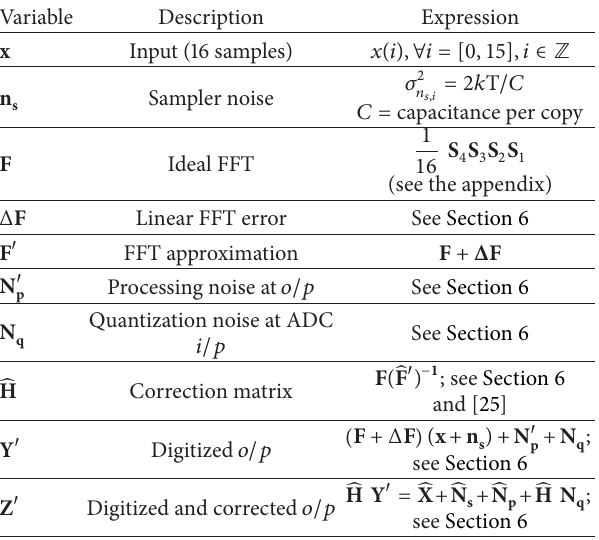
Table 1: Summary of variables in LTI